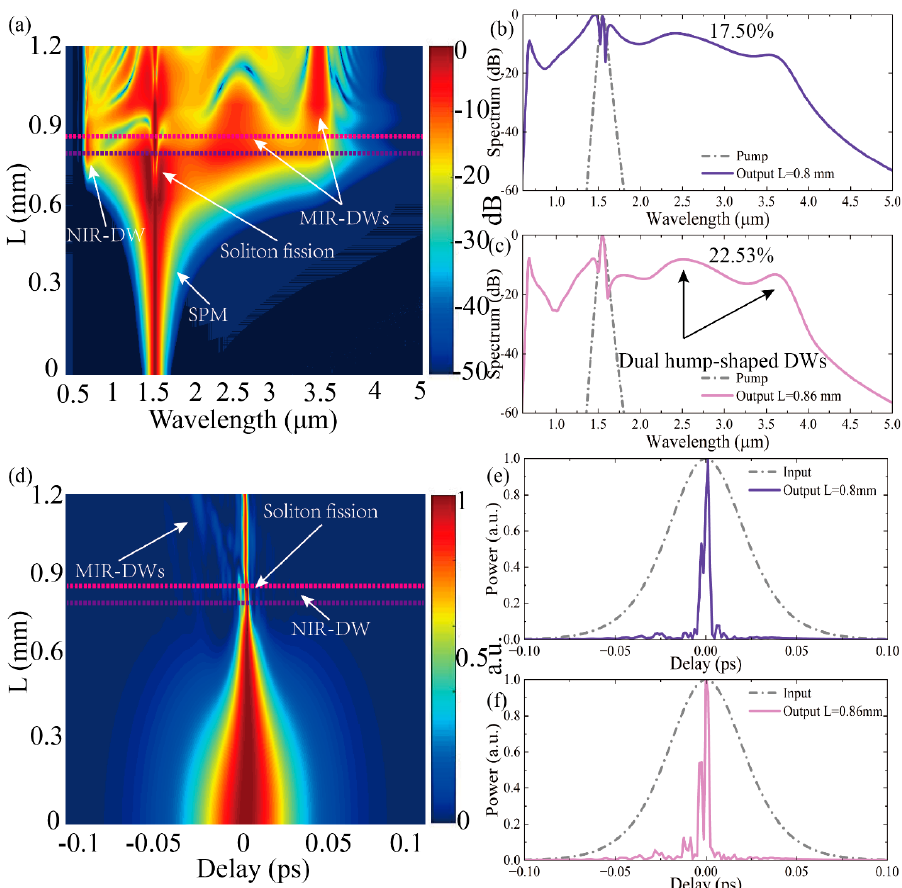
Figure 4. ( a ) Spectral evolution along the propagation length with the full-width at half maxima τ FWHM = 50 fs. ( b ) The spectra of the pump and the output at L = 0.8 mm. ( c ) The spectra of the pump and the output at L = 0.86 mm. ( d ) Temporal evolution along the propagation length with the full-width at half maxima τ FWHM = 50 fs. ( e ) The normalized temporal pulse envelopes at input and output at L = 0.8 mm. ( f ) The normalized temporal pulse envelopes at input and output at L = 0.86 mm.